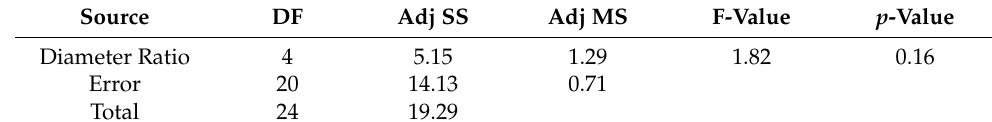
Table 6. ANOVA of the influence of diameter ratio on the neck radius.